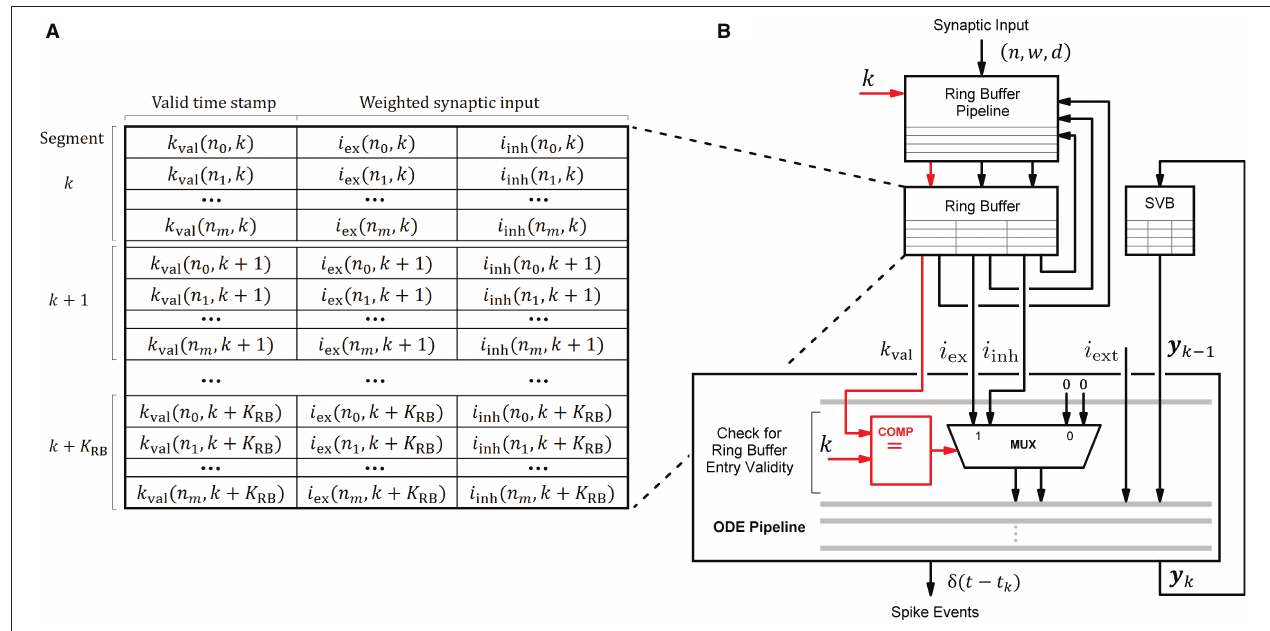
FIGURE 10 | Ring buffer (RB) architecture and interaction of components. Local variables are stored in the ring buffer (RB) and the state variables buffer (SVB). For their implementation fast, low-latency on-chip BRAM memories were used. Shown is the interaction of the RB pipeline and the ODE pipeline which both operate on the RB. To avoid additional write operations by the ODE pipeline to invalidate the RB entries when processed, each entry is provided with a time stamp k val that indicates the RB cycle for which it is valid. The value of k val is calculated by the RB pipeline—see also the RB update algorithm ( Figure 11 )—and compared with the current simulation time step to verify an entry’s validity when read by the ODE pipeline for processing. The principle is illustrated in (B) where the data path is marked in red. The corresponding RB layout is shown in (A)